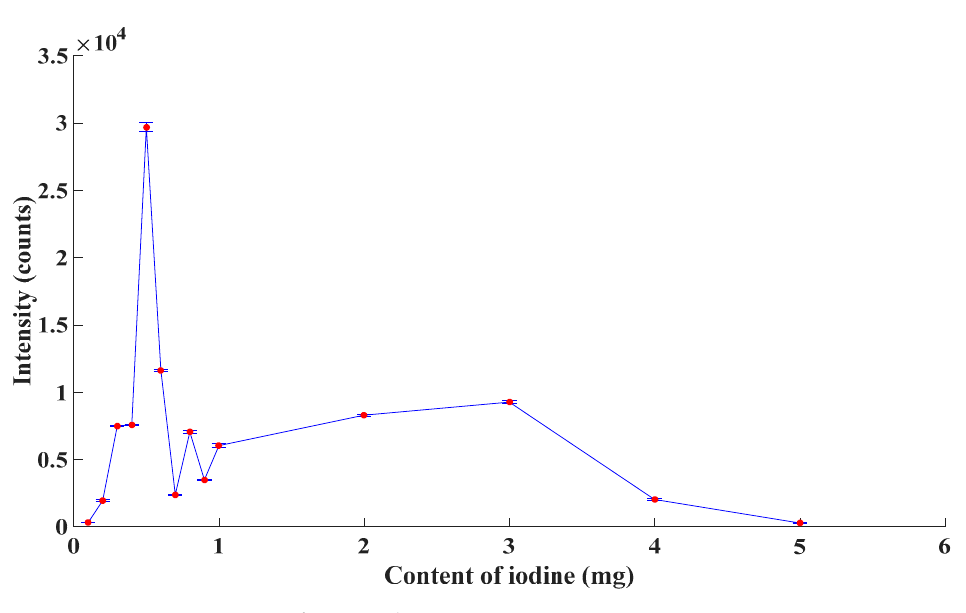
Figure 2. Emission intensity of excimer lamps.